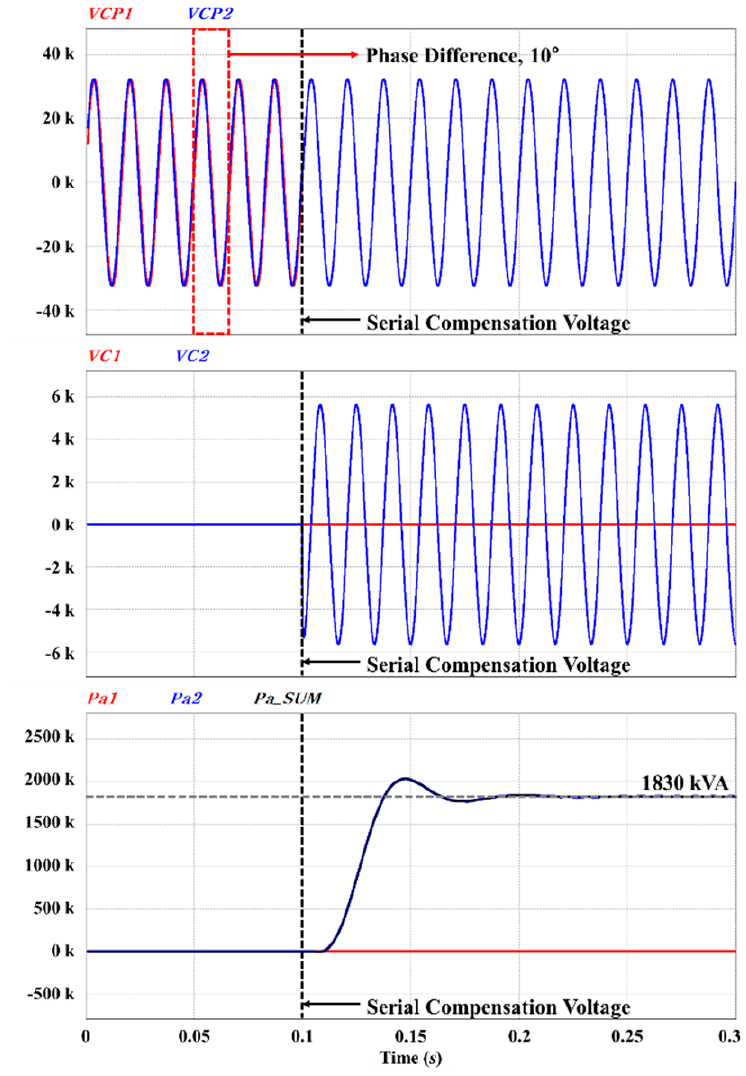
Figure 11. Connection point voltage and APC capacity at the controlled angle of 0°.